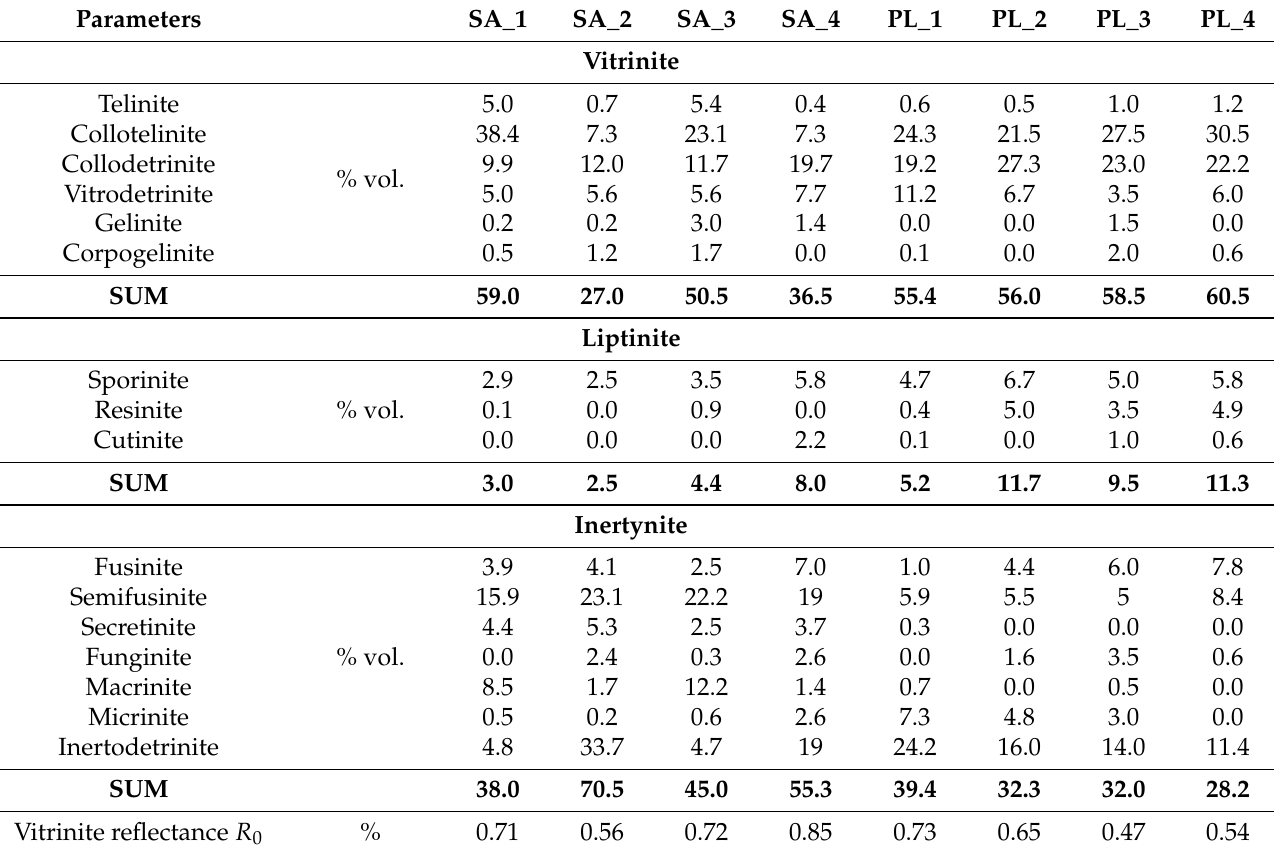
Table 2. Composition of basic macerals for the tested